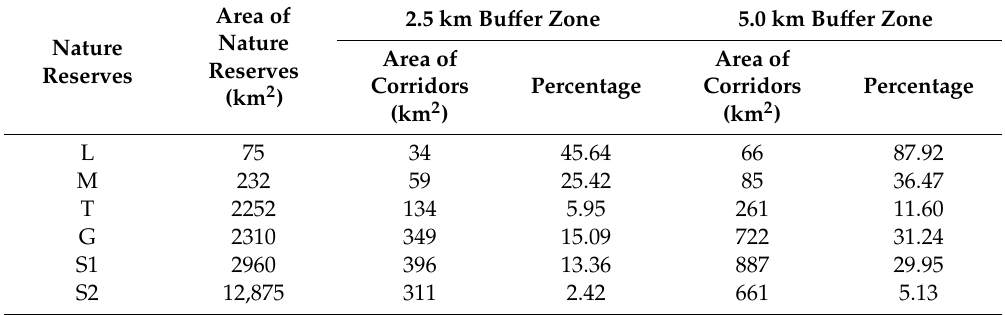
Table 8. Percentage of potential corridors in nature reserves. Sanjiangyuan National Nature Reserve (S1, S2), Gahai-Zecha National Nature Reserve (G), Lianhuashan National Nature Reserve (L), Mengda National Nature Reserve (M), Taohe National Nature Reserve (T). Area Nature Reserves